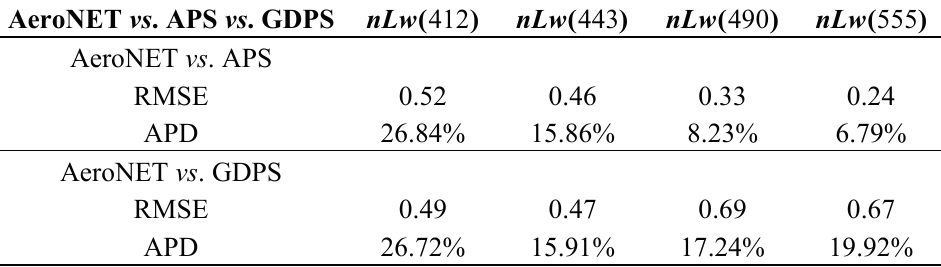
Table 2. RMSE 2 [mW/(cm sr μ m)] and APD (%) between AeroNET, APS, and GDPS results at the Ieodo